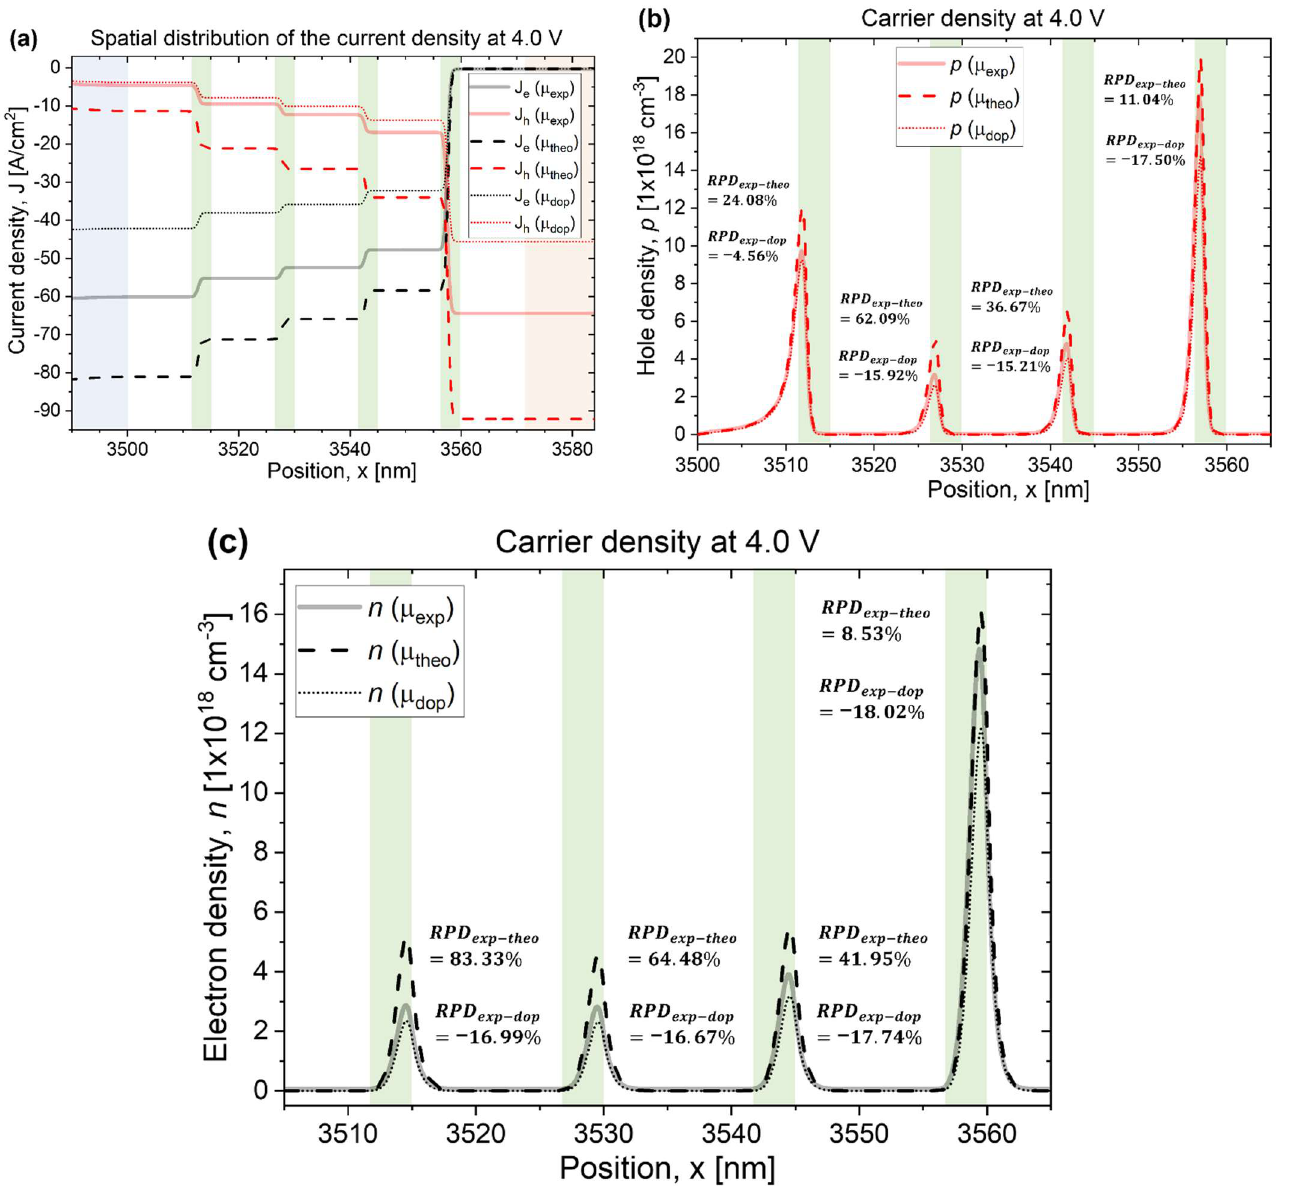
Figure 8. ( a ) Spatial distribution of current density, ( b ) hole, and ( c ) electron density in the active layer of the LED at 4.0 Volts. Table 2. Relative Percentage Difference for radiative recombination from In 0.15 Ga 0.85 N/GaN at different voltage